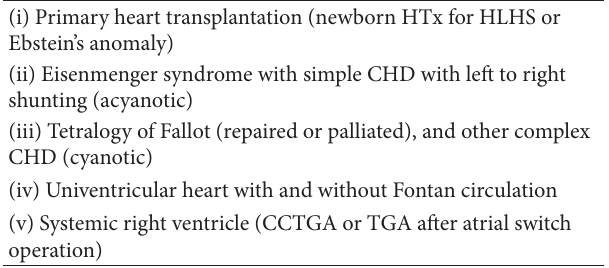
Table 1: Main reasons for heart transplantation in congenital heart disease.